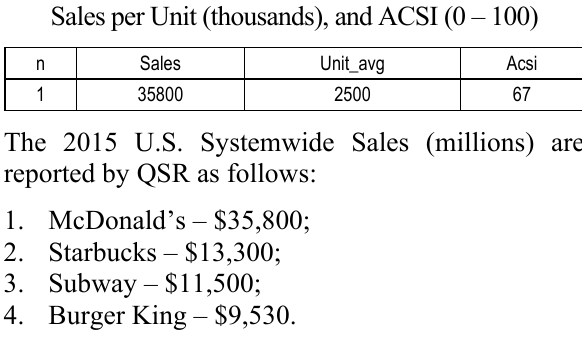
Table 7. QSR (Sales > 1500): Sales (millions),